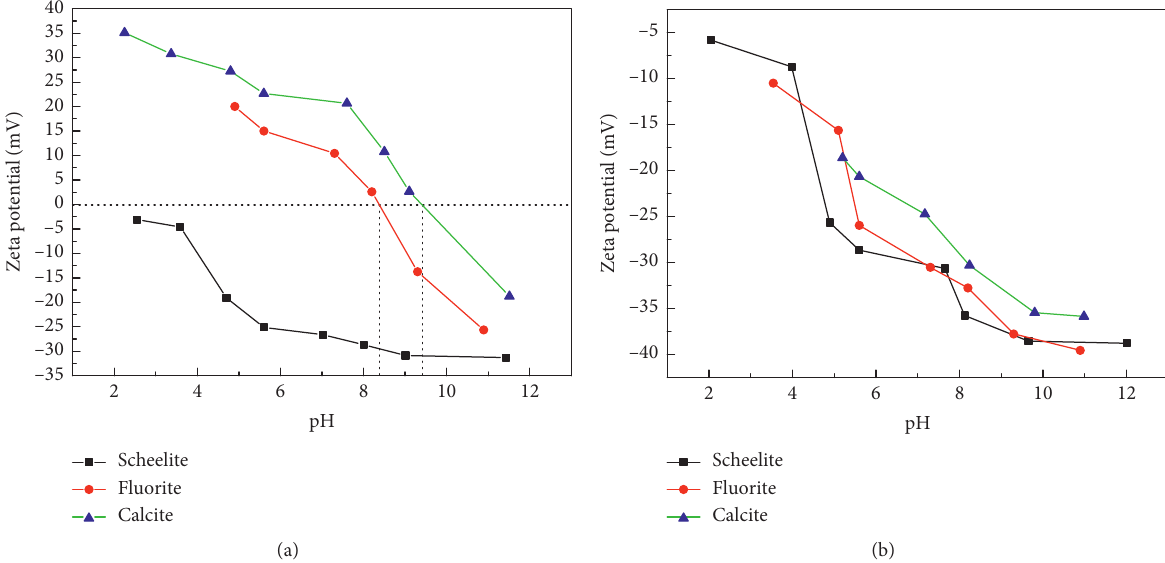
Figure 6: Zeta potentials of scheelite, fluorite, and calcite in (a) aqueous solution and (b) 1mM sodium oleate solution.